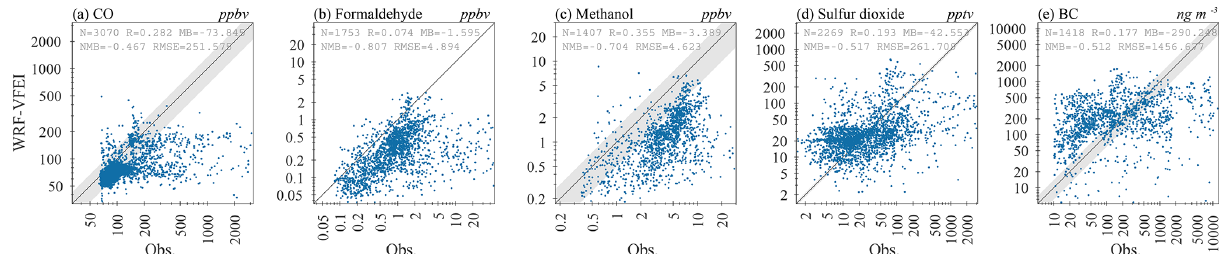
Figure 12. Scatter plots comparing the airborne data from the FIREX-AQ campaign in North America and the WRF-VFEI simulations between 24 July and 8 August 2019. (a) Carbon monoxide (in ppb), (b) formaldehyde (in ppb), (c) methanol (in ppb), (d) sulfur dioxide (in ppt), and (e) black carbon in (ngm − 3 ). Statistics are reported in each panel, such as the number of points ( N ), correlation ( R ), mean bias (MB), normalized mean bias (NMB), and root mean squared error (RMSE).